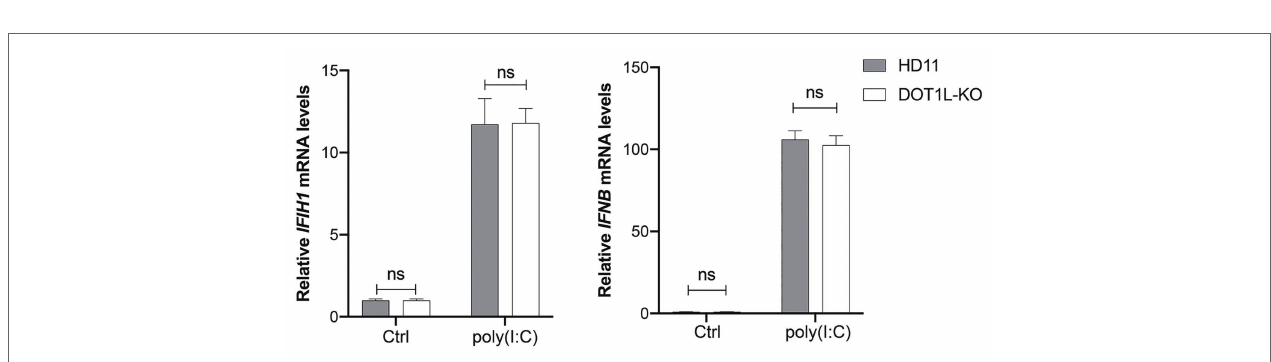
FIGURE 6 | Knockout of DOT1L promotes defense response to ALV-J infection. (A) Heatmap of representative genes involved in type I IFN‐ related genes from DOT1L-KO vs. control cells infected with ALV-J at 24 h. (B) qRT-PCR validations. (C) HD11 cells were infected with ALV-J (MOI 2) in the presence of 5 μ M EPZ or vehicle control (DMSO). At 48 hpi, the relative expression of IFIH1 , IFN β , STAT1 , and MX1 were determined by qRT-PCR. GAPDH were used as internal control. All the data were shown as mean ± SD (error bars) from three independent experiments. * p < 0.05; ** p < 0.01; *** p < 0.001; unpaired, two-tailed Student’s t